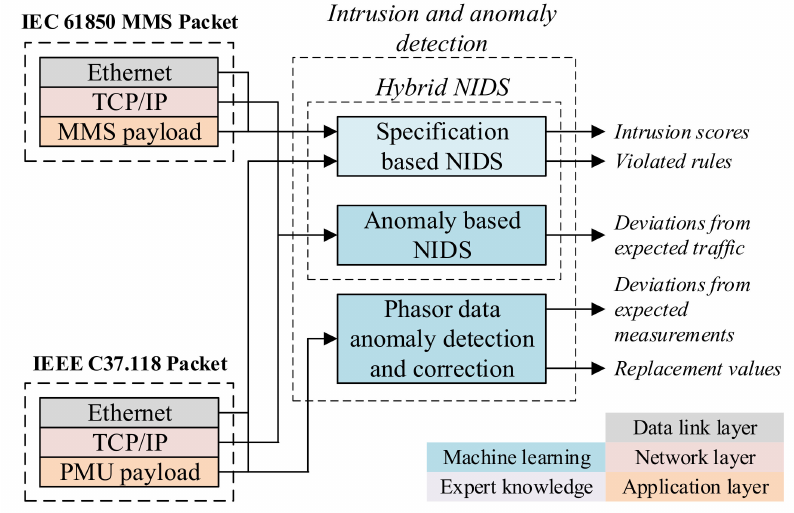
Figure 2. Main workflow and components of the network intrusion and anomaly detection